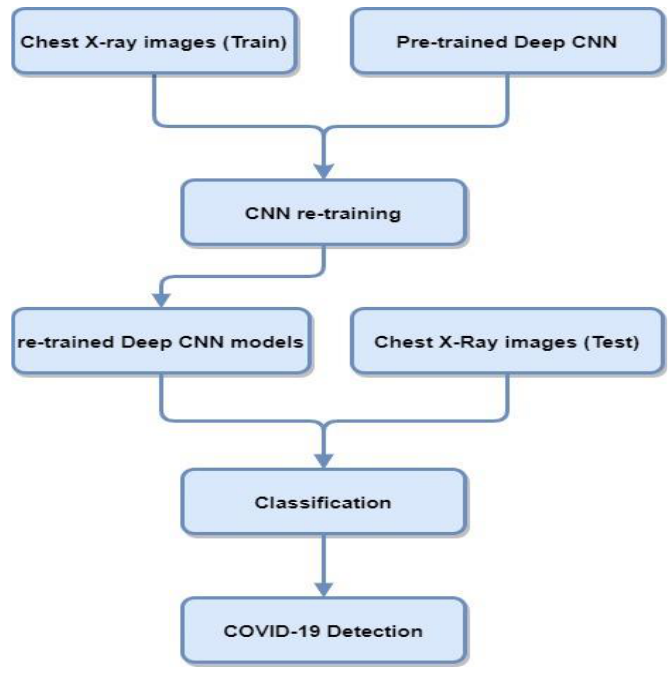
Figure 3. Block diagram of deep CNN architectures using CXR for COVID-19 detection.